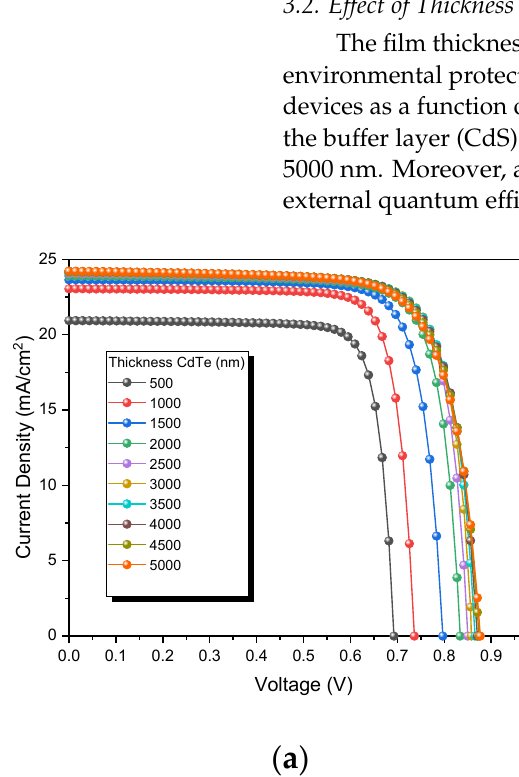
Figure 2. Base solar cell (C/CdTe/CdS/SnO 2 ): ( a ) J-V curve, ( b ) the external quantum efficiency.